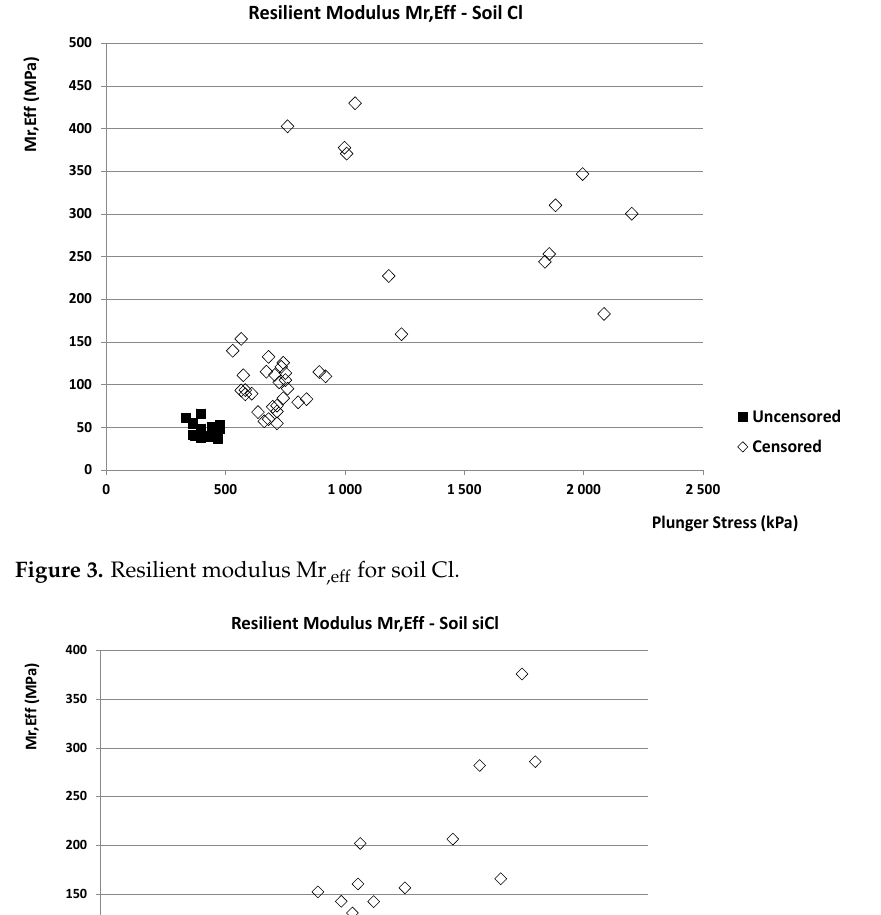
Figure 4. Resilient modulus M r,eff for soil siCl.